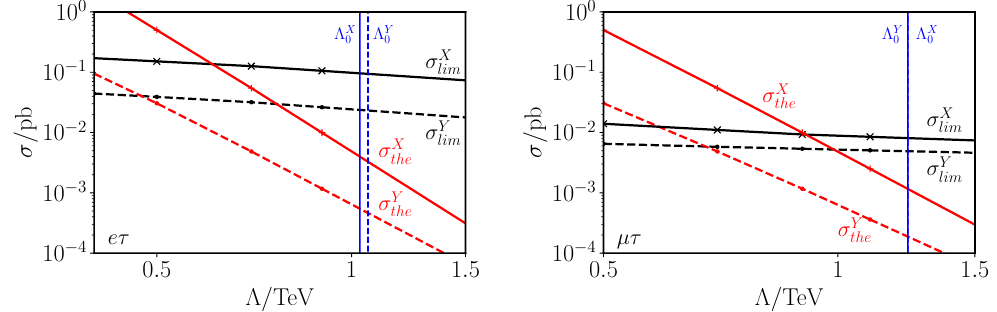
Figure 3 . Left: the invariant mass distribution of selected e(cid:22) pairs for 1 and 1 : 5 TeV normalised to the same cross section. Right: the blue solid (dashed) line shows the upper limit on the production cross section at 95% C.L. for the operator EFT. The red solid (dashed) line denotes the predicted cross section for the operator the unitarised EFT. The upper limit in the unitarised EFT is shown as a black solid (dashed) line for the operator ( ). The lower limit on (cid:3) u is the intersection of the red and black lines. O X O Y